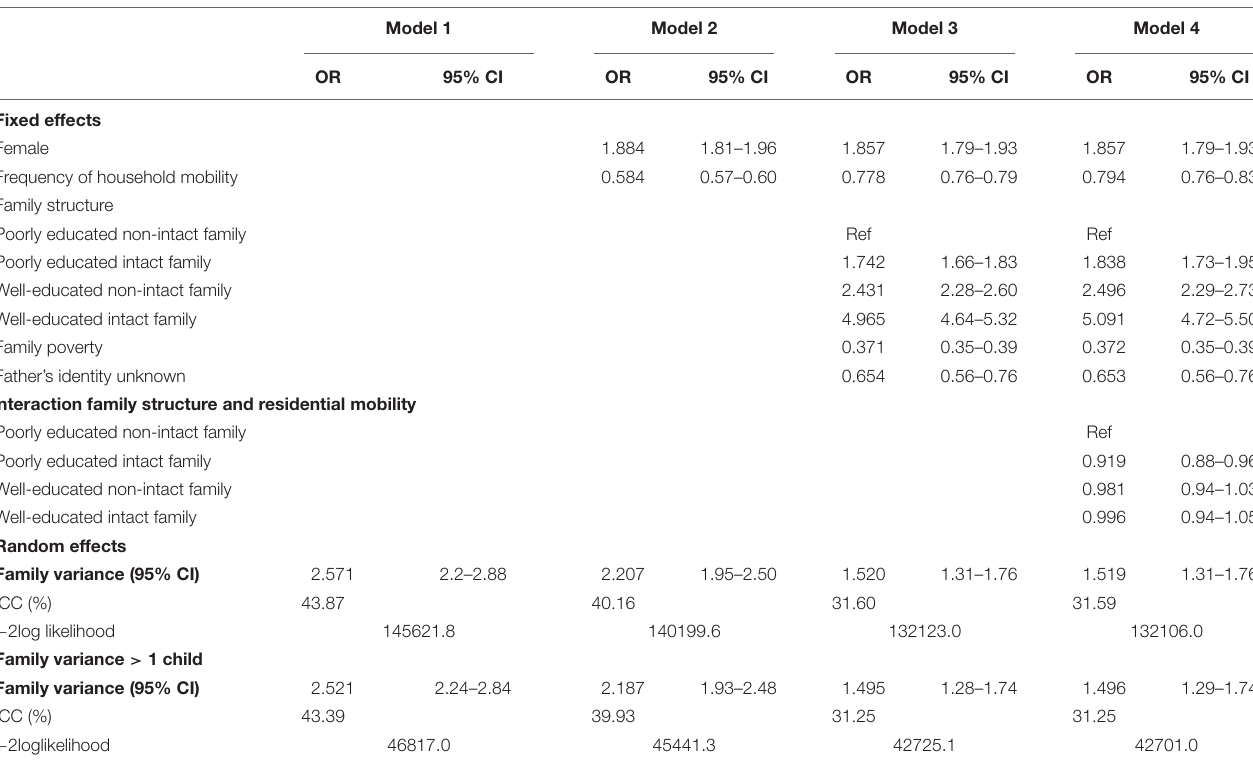
TABLE 2 | The impact of residential mobility and its interaction with family structure (education level and family living situation) on the probability of completing upper secondary education.